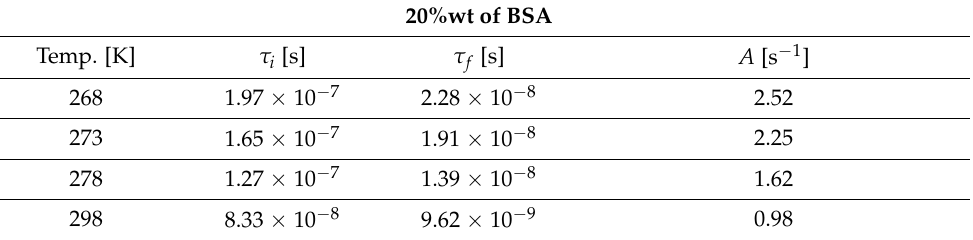
Table 1. Parameters obtained from the analysis of 1 H spin-lattice relaxation data for BSA–water mixtures at higher temperatures (268 K and above) in terms of Equation (1). The dipolar relax- ation constants, C DD and C DD , for 20%wt concentration of BSA yields: C DD i f C DD = 2.16 × 10 7 Hz 2 . The dipolar relaxation constants for 40%wt concentration of BSA are: f C DD s = 5.61 × 10 6 Hz 2 , C DD